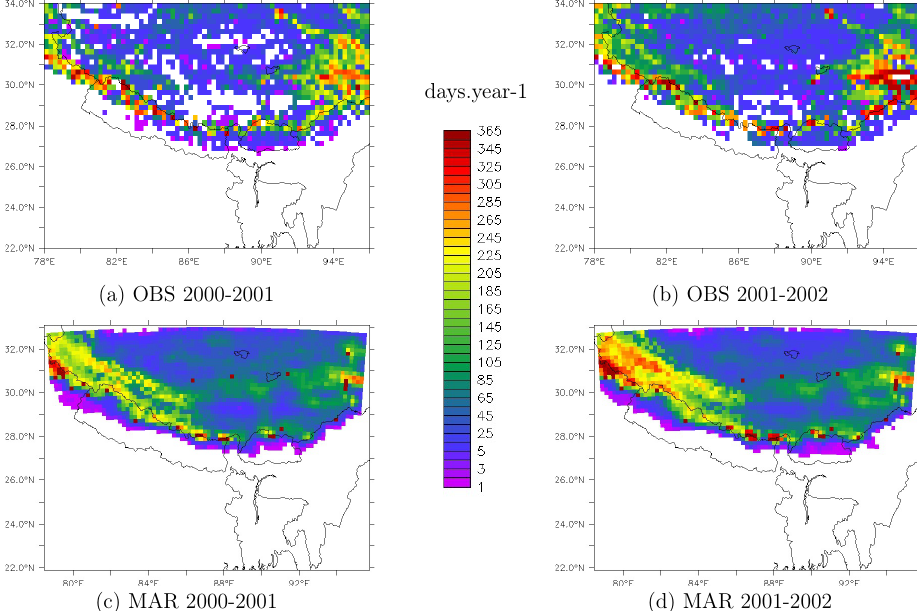
Fig. 6. Snow cover duration: (a) 2000–2001 and (b) 2001–2002 IMS observation (NSIDC, 2004); (c) 2000–2001 and (d) 2001–2002 MAR simulation. Annual values are computed from October to